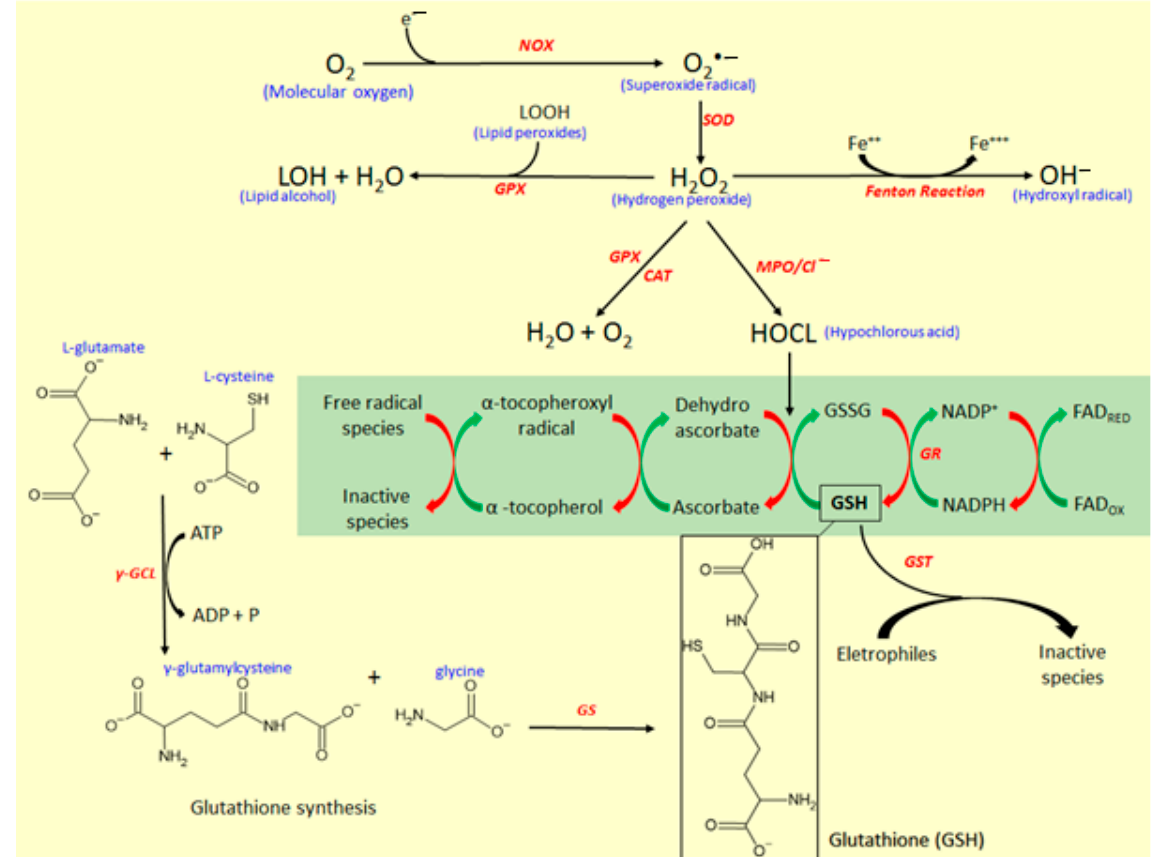
Figure 5. Free radical production and glutathione (GSH) antioxidant system. CAT, catalase; GPX, glutathione peroxidase, GR, glutathione reductase; GS, glutathione synthetase; GST, glutathione S-transferase; NOX, NADPH oxidase; MPO, myeloperoxidase; SOD, superoxide dismutase; γ -GLC, γ -glutamylcysteine ligase. In these oxidative processes, the following activities were reported: A. Counteraction of GSH depletion by paepalantine, coumarin, 4-hydroxycoumarin, esculetin, 4-methylesculetin, daphnetin, esculin, scopoletin, scoparone, and fraxetin; B. Inhibition of MPO activity by paepalantine, esculetin, 4-methylesculetin, daphnetin, and esculin; C. Scavenging activity of free radical by paepalantine, daphnetin, esculin, scopoletin, scoparone, and fraxetin; D. Inhibition of lipid peroxidation by esculetin, and daphnetin; E. Inhibition of GPX activity and expression by 4-methylesculetin; F. Increase of GST and GR activity and expression by 4methylesculetin. Chemical structures were drawn using ACD/ChemSketch